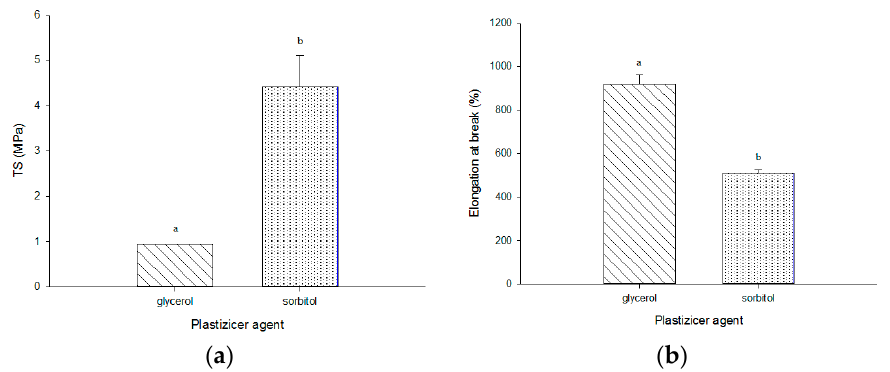
Figure 6. ( a ) Tensile strength and ( b ) elongation at break of protein films from jumbo squid ( Dosidicus gigas ) with glycerol and sorbitol as plasticizers. The values are the means of 12 determinations ± the standard deviation. Different letters show significant differences ( p < 0.05).